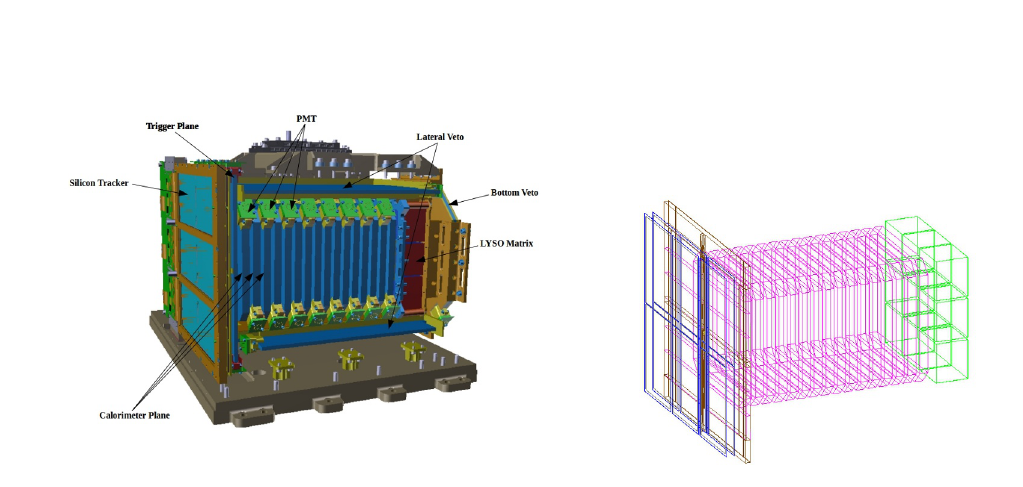
Figure 1. Left: An overview of HEPD. The trigger plane, below the silicon planes, is not visible. Right: example of the graphic transparent visualization of HEPD MC software; veto planes, HEPD box, satellite wall and passive materials are not